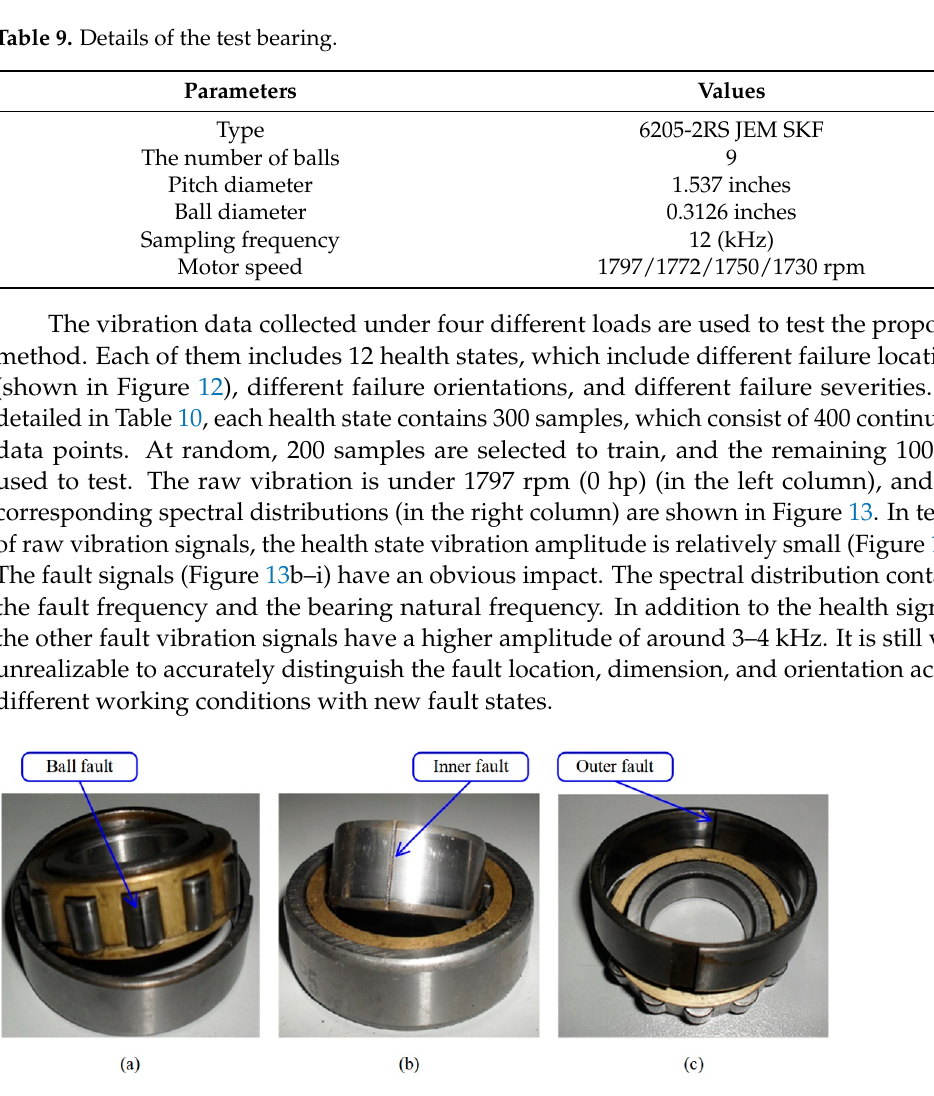
Figure 12. The faults of bearing in three locations: ( a ) ball fault; ( b ) inner fault; ( c ) outer fault.